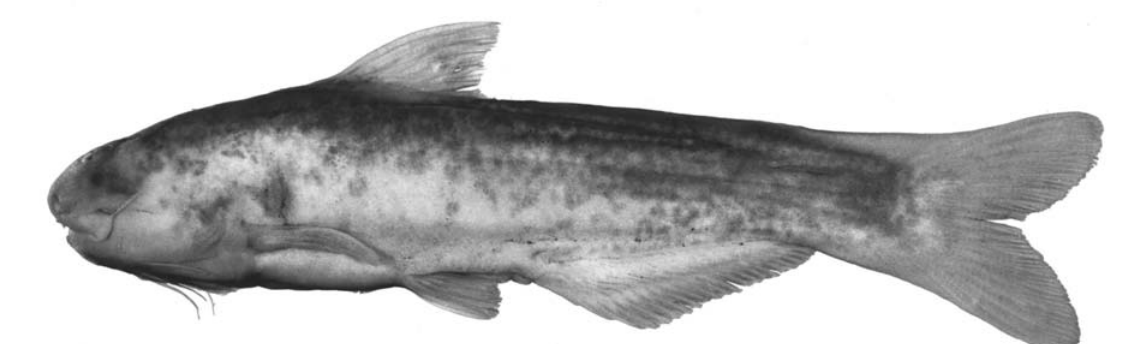
Fig. 21. Cetopsis gobioides, MZUSP 51539, 50 mm SL; Brazil, Minas Gerais, Fortuna de Minas, rio Paraopeba, Fazenda Chaparral.